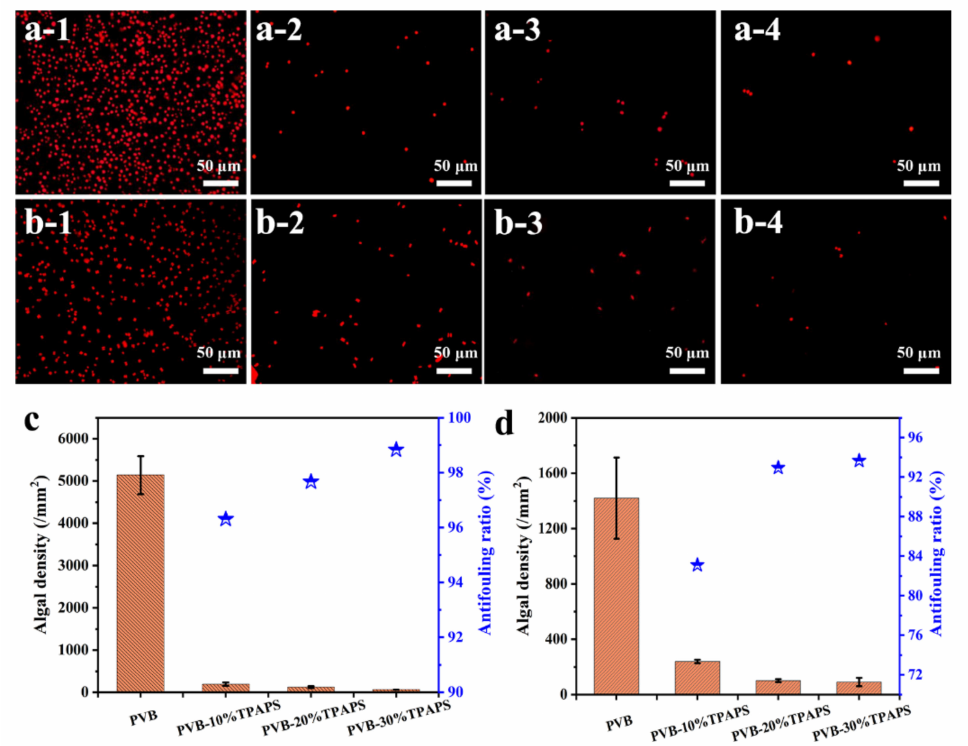
Figure 9. Anti-algae-adhesion performance of PVB-X%TPAPS coatings. The typical fluorescence microscopy images of the adhered Porphyridium sp. ( a ) and Navicula sp. ( b ) for PVB (1), PVB- 10%TPAPS (2), PVB-20%TPAPS (3) and PVB-30%TPAPS (4) after 24 h incubation. The statistical charts of adhesive algae densities and their antifouling ratios (the blue stars) for Porphyridium sp. ( c ) and Navicula sp. ( d ),